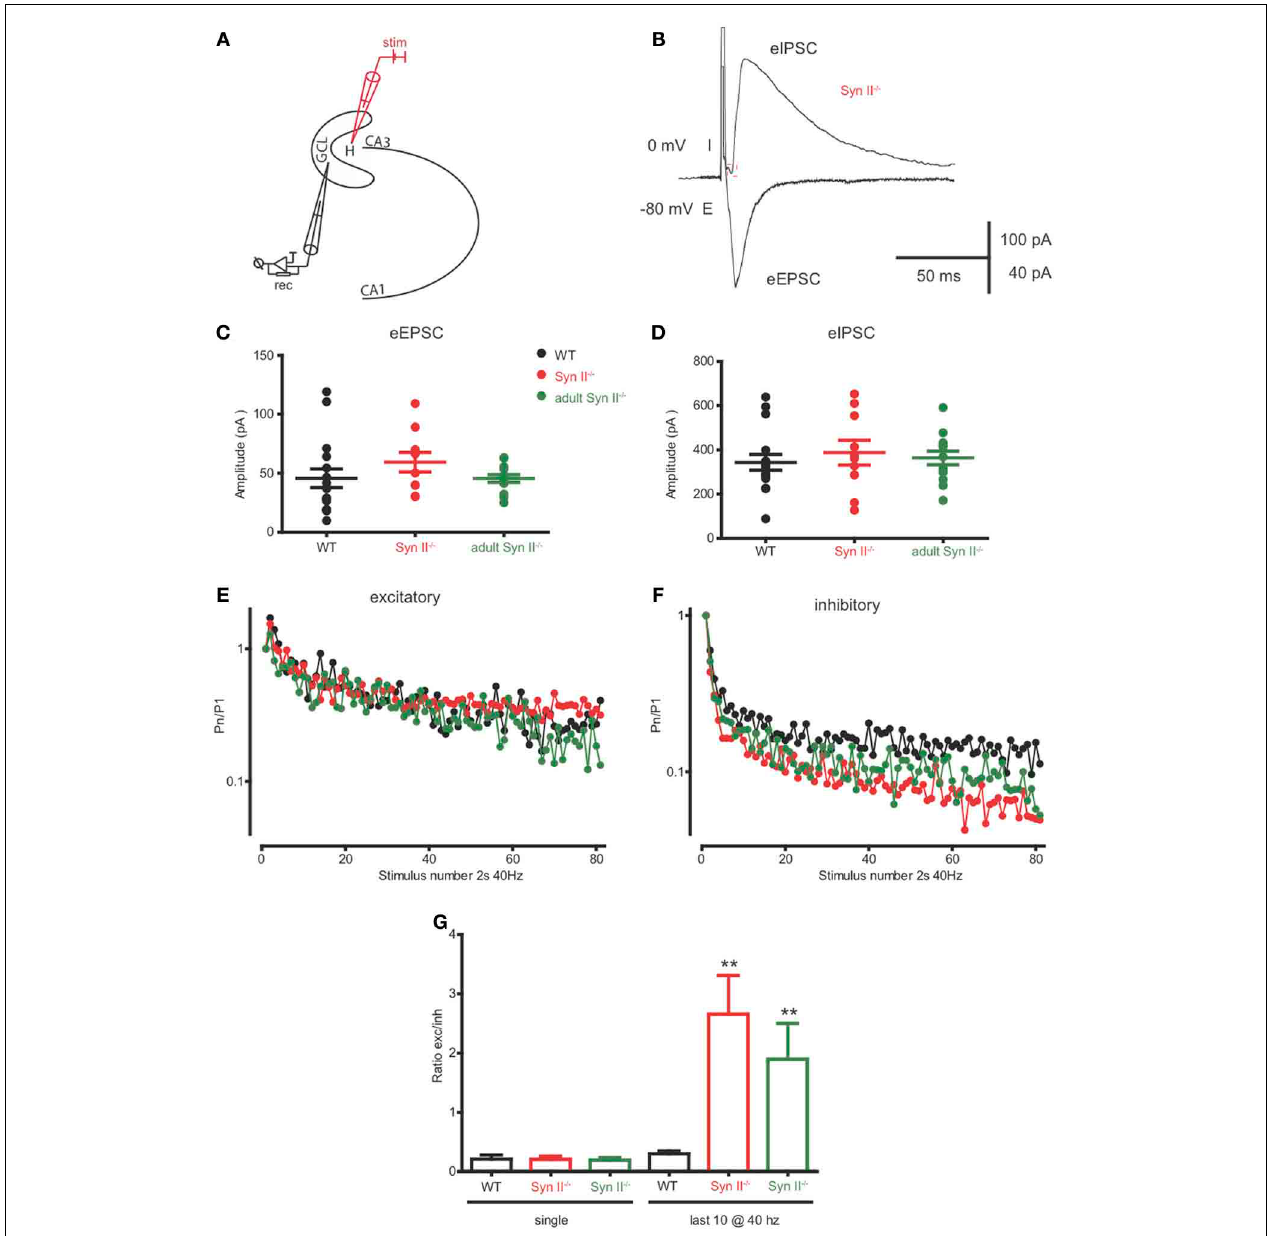
the normalized mean amplitude of excitatory (E) or inhibitory (F) responses vs. time showing the multiple-pulse depression during a 2-s train at 40Hz in young WT (black), pre-symptomatic (red) and symptomatic (green) Syn II − / − mice. (G) Mean ( ± s.e.m.) ratio between the amplitudes of eEPSCs and eIPSCs from the same granule neurons (young WT, black; pre-symptomatic Syn II − / − , red; symptomatic Syn II − / − , green) in the case of a single stimulus (left) or for the last 10 stimuli in a 40Hz train (right); ∗∗ p < 0 . 001, Kruskal–Wallis test followed by Dunn’s multiple comparison test.